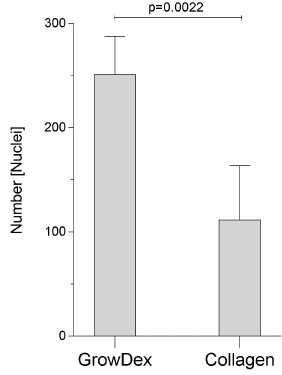
Figure 3. Quantitative analyses of nuclei within GrowDex ® and rat-tail collagen. Di ff erentiated cells revealed a significantly higher cell number within the birch-based hydrogel on day 15 post-ALI. Five independent regions of two Transwell inserts were quantified using the Operetta CLS ™ HCS, and cells were automatically quantified using the Harmony